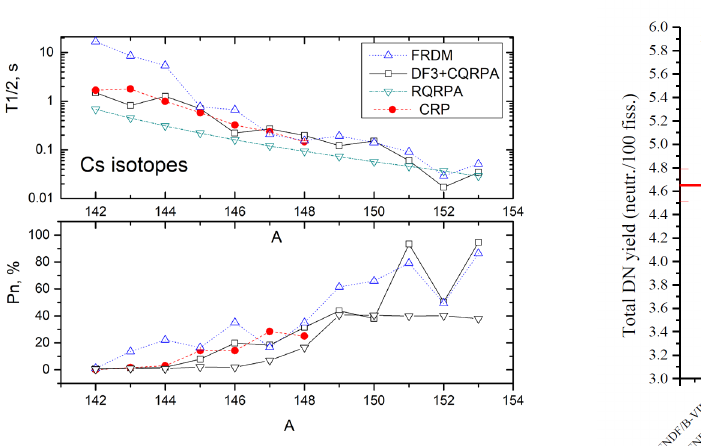
Figure 1. Evaluated ( T 1 / 2 , P xn ) compared with model calcula- tions from DF + cQRPA [15], RQRPA [16] and FRDM [17] for Cs isotopes.